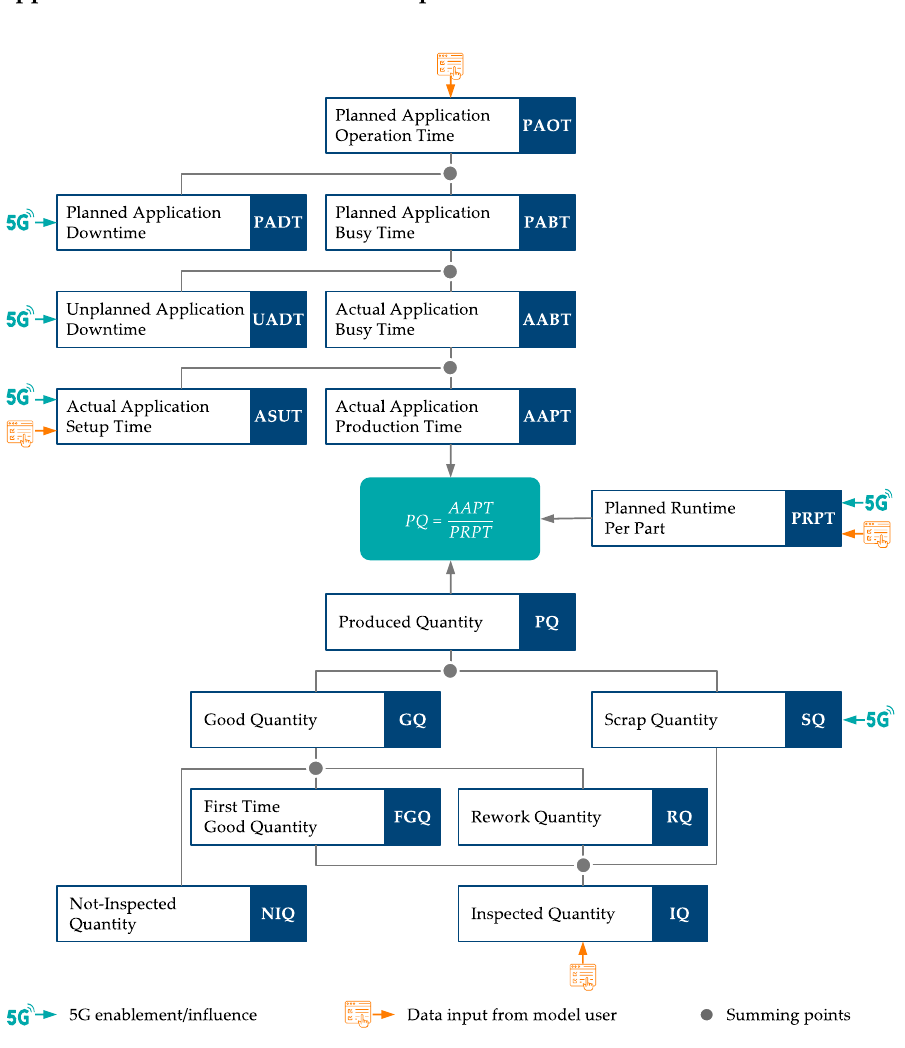
Table A1. List of formula symbols.